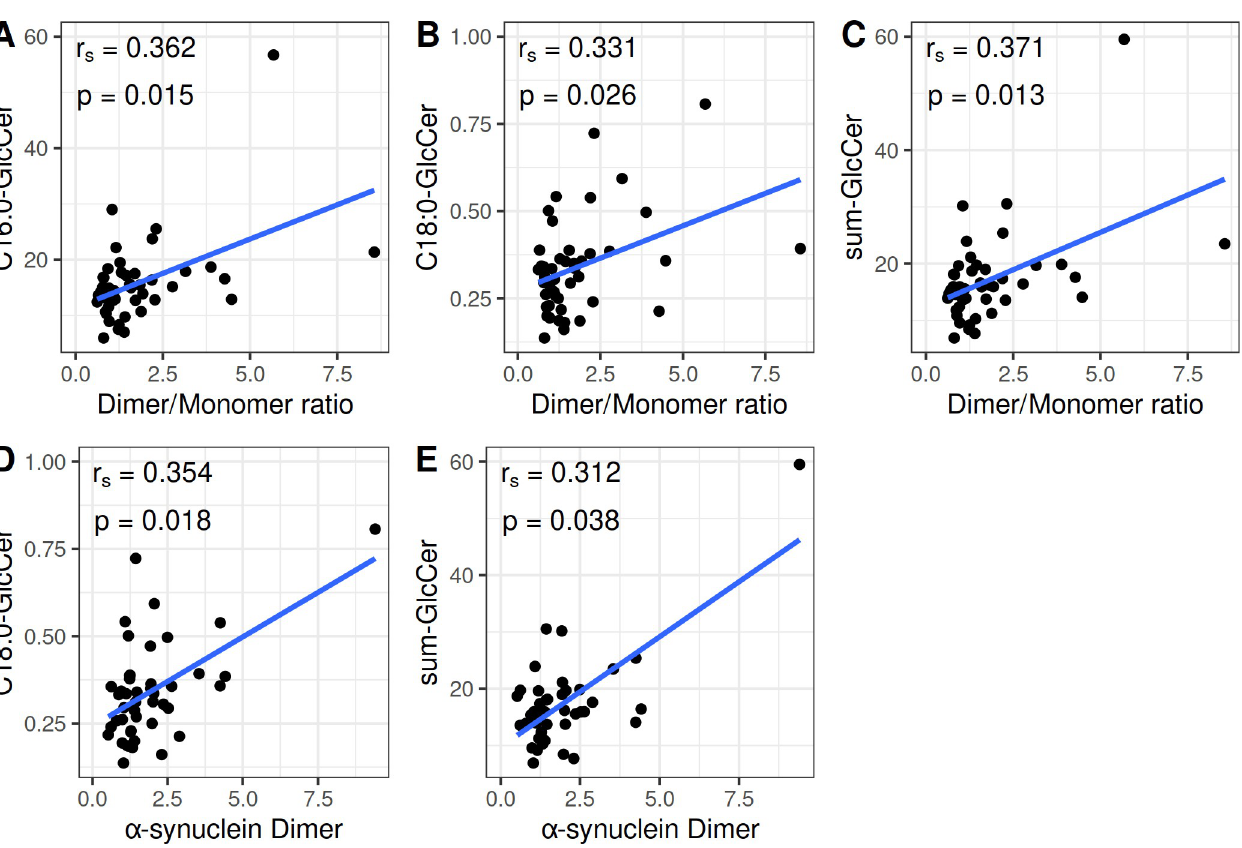
Fig 4. Statistically significant correlations between the α -Synuclein species and the lipids studied in Gaucher disease patients receiving no treatment. Correlation between (A) the α -Synuclein dimer/monomer ratio and N-palmitoyl-glucosylceramide (C16:0-GlcCer), (B) the α -Synuclein dimer/monomer ratio and N-stearoyl-glucosylceramide (C18:0-GlcCer), (C) the α -Synuclein dimer/monomer ratio and the sum of glucosylceramide species (sum-GlcCer), (D) the α -Synuclein dimer and N-stearoyl-glucosylceramide (C18:0-GlcCer), (E) the α -Synuclein dimer and the sum of glucosylceramide species (sum- GlcCer). C16:0-GlcCer, C18:0-GlcCer and sum-GlcCer are expressed in pmoles/10 8 cells. The α -synuclein dimer is expressed as the ratio of dimeric α -Syn to GAPDH. The α -synuclein dimer/monomer ratio is expressed as the ratio of dimeric to monomeric α -Syn.